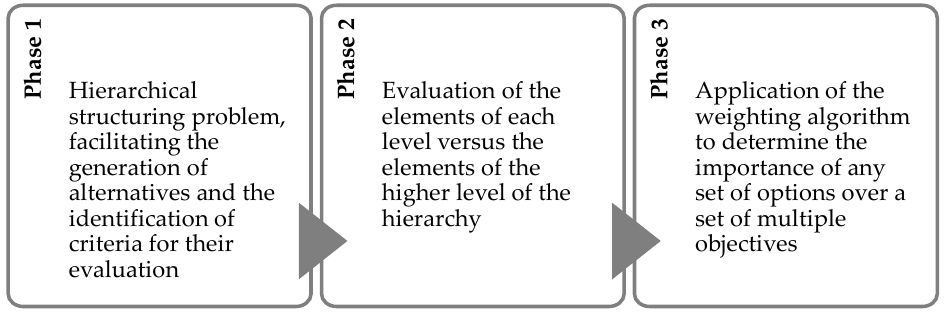
Figure 6. Phases of the AHP method.